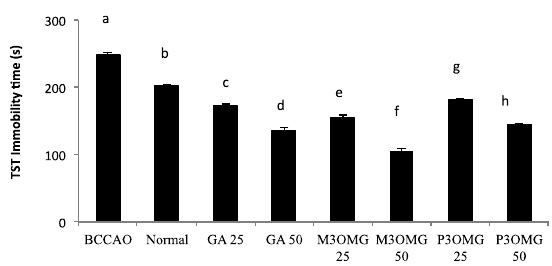
Figure 6. Effects of the intraperitoneal administration of GA, M3OMG and P3OMG on the tail suspension model. Data are a mean (s) ± SD ( n = 7); different letters indicate statistically significant differences ( p < 0.01) between the two groups.